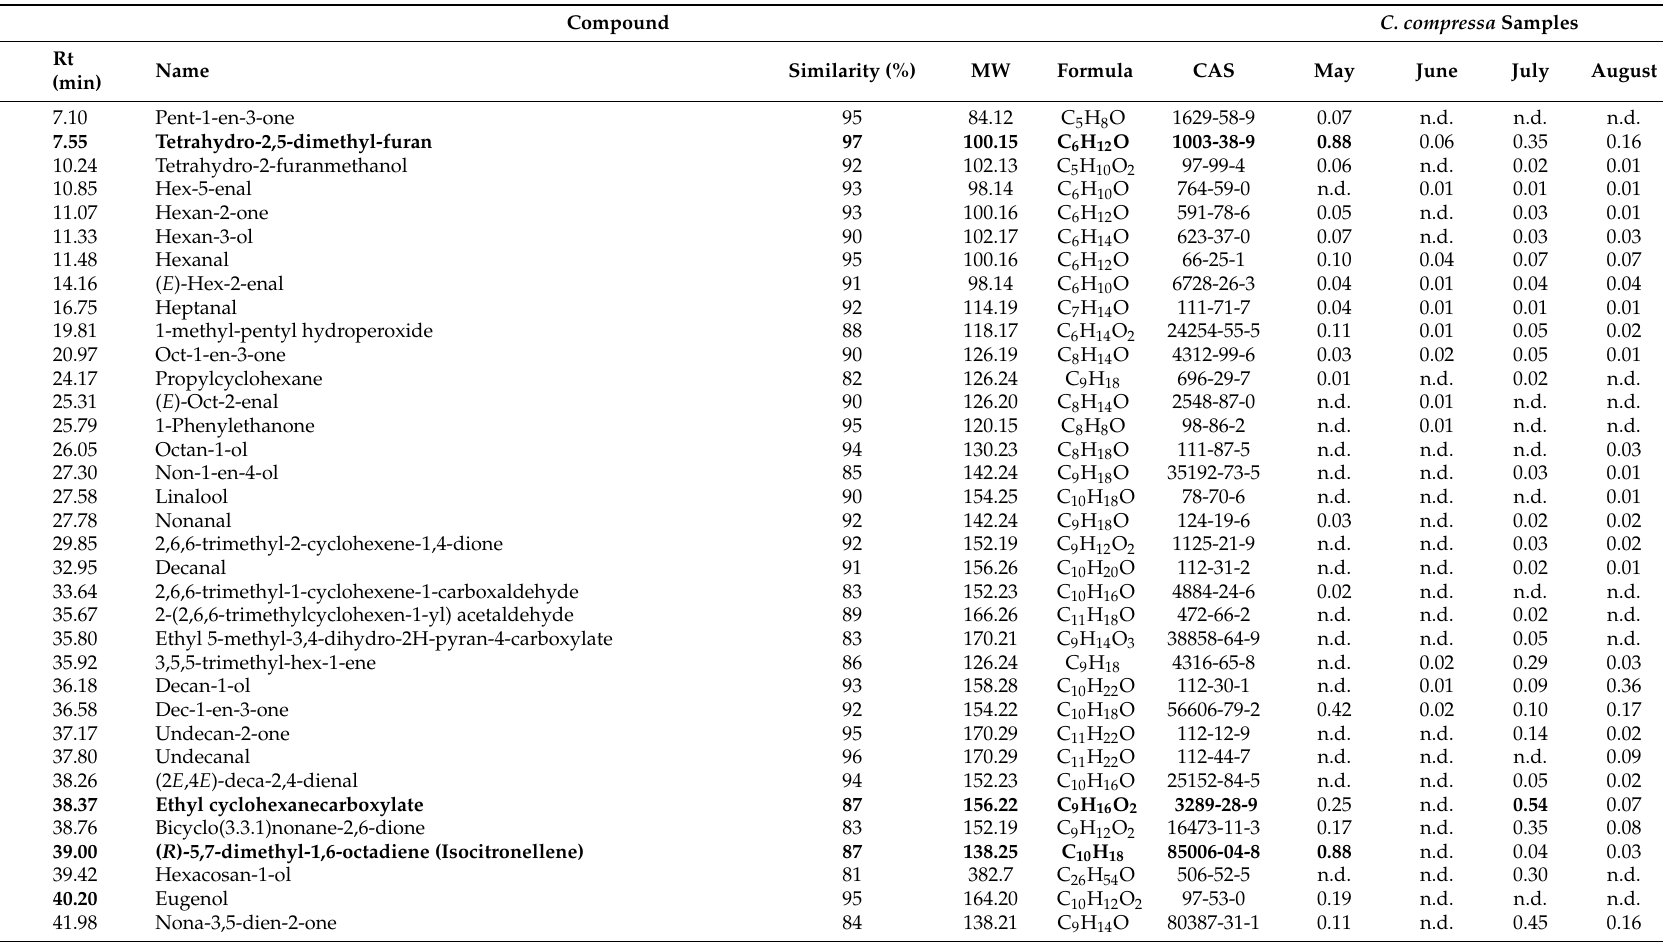
Table 1. Differences in the chemical composition of essential oils of C. compressa harvested in different periods. The data are expressed as relative percentages of each single peak area with respect to the total peak